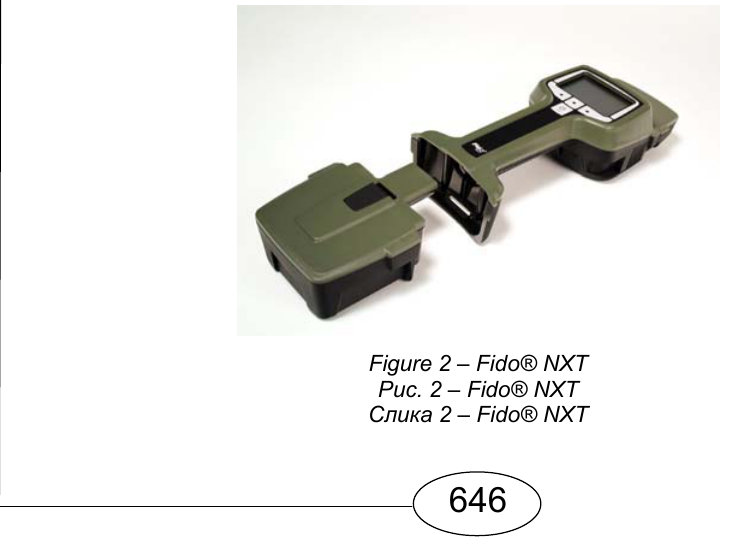
Figure 2 – Fido® NXT Рис . 2 – Fido® NXT Слика 2 – Fido®